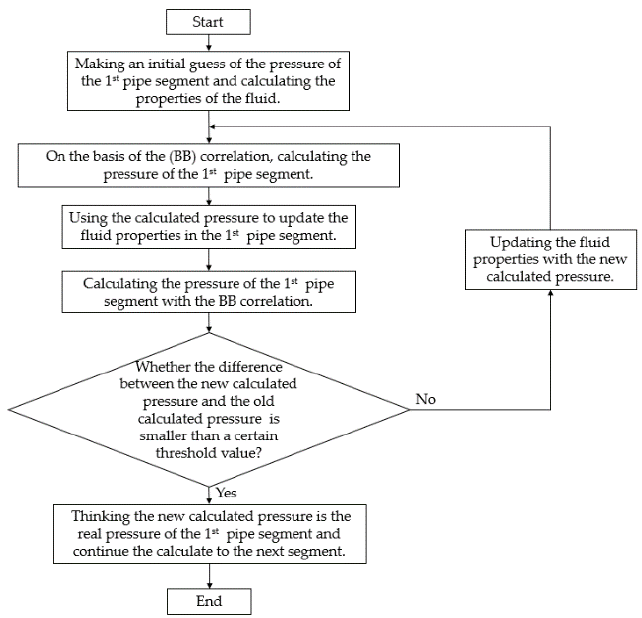
Figure 8. Flow chart of the process for calculating the pressure of a discretized pipe.